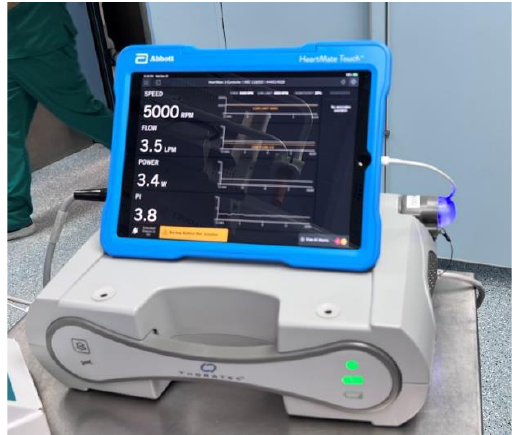
Figure 4. Speed and flow of